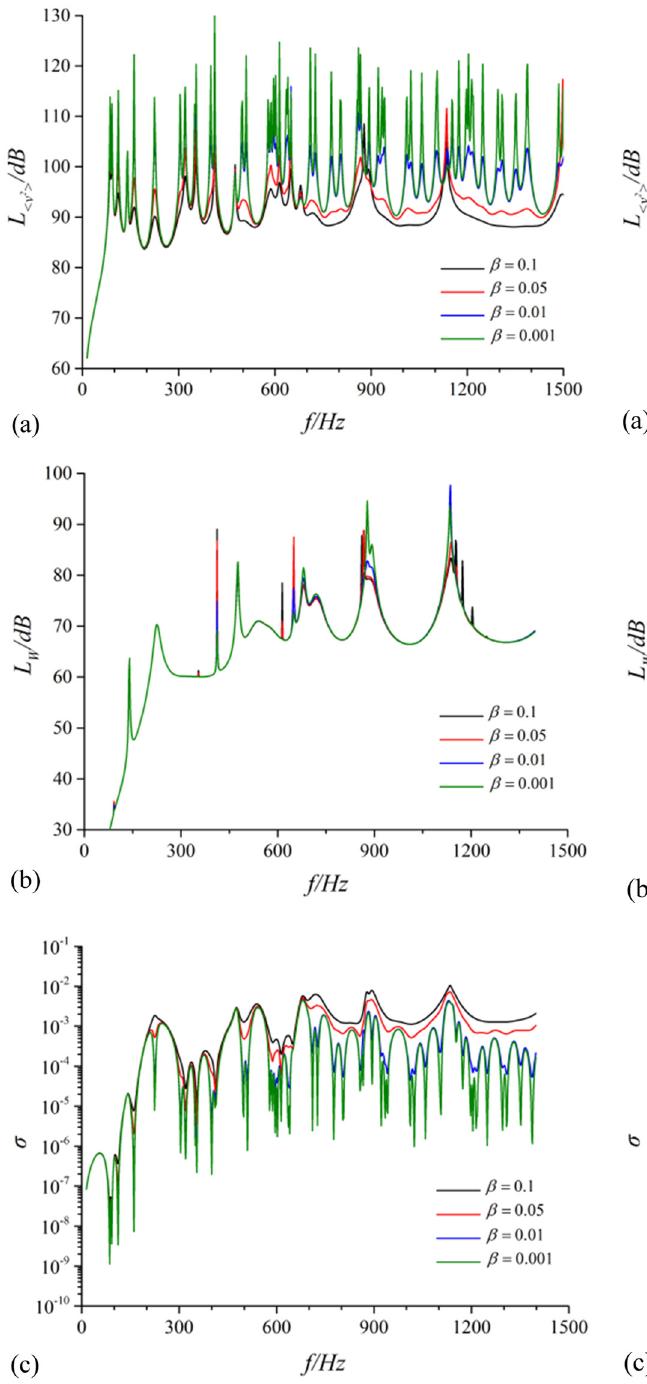
Figure 6: Contrast of vibration and noise performance for the cylindrical shell under di ff erent Poisson ratios. ( a ) Radial quadratic velocity level, ( b ) sound radiation power level, and ( c ) sound radiation e ffi